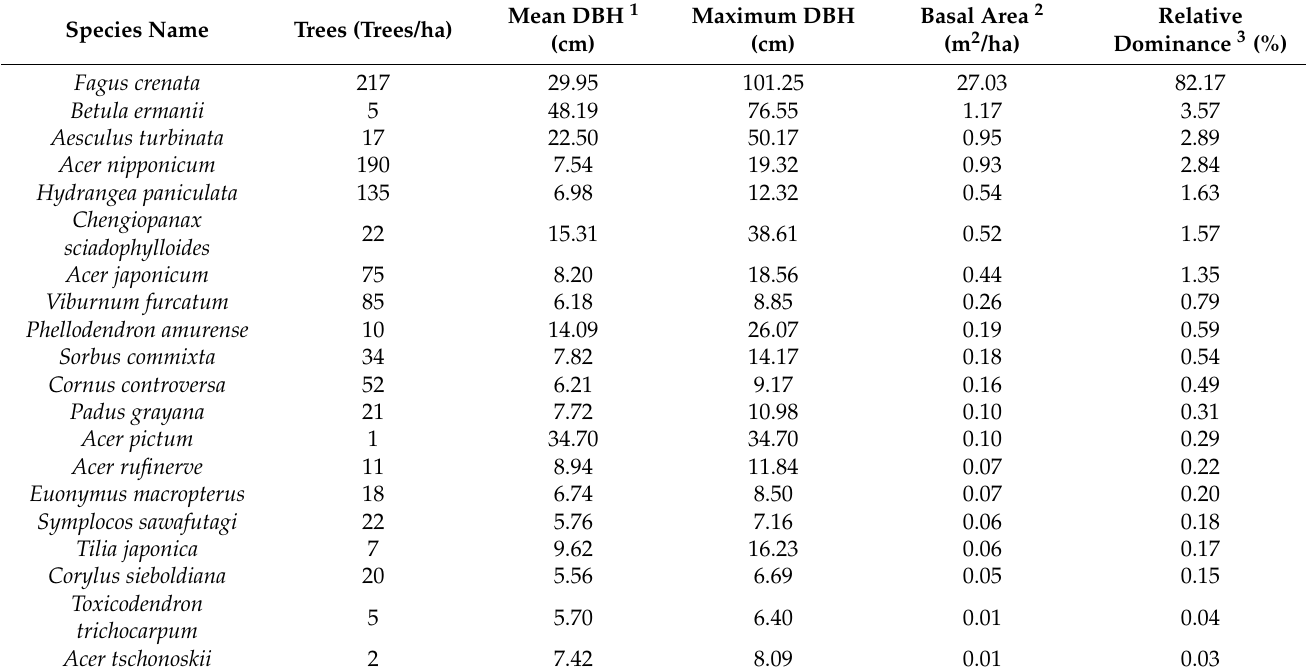
Table 1. Vegetation structure of the study plot (species are listed in descending order of relative dominance).